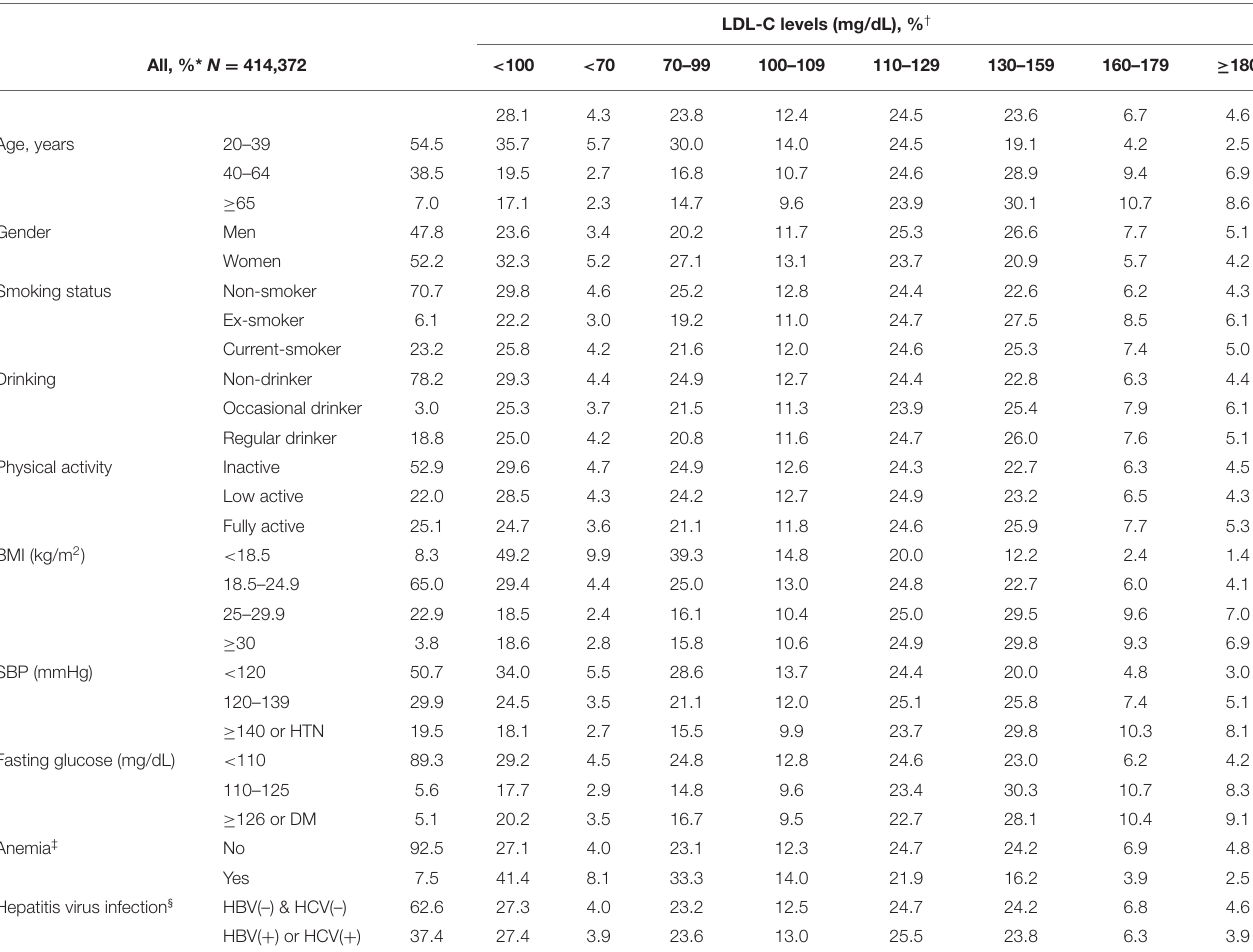
TABLE 1 | Distribution of characteristics by LDL-C levels in MJ